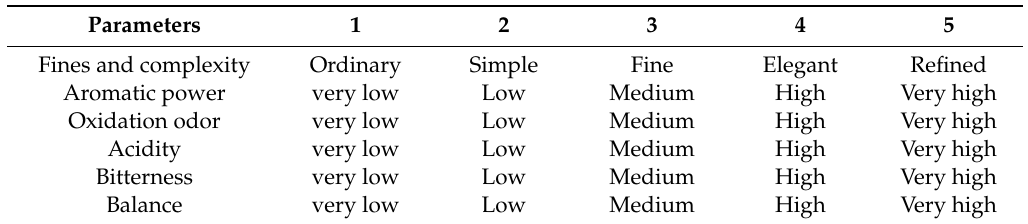
Table 3. Principle aspects of the wine tested with a given score scale (from 1 to 5) during the sensorial